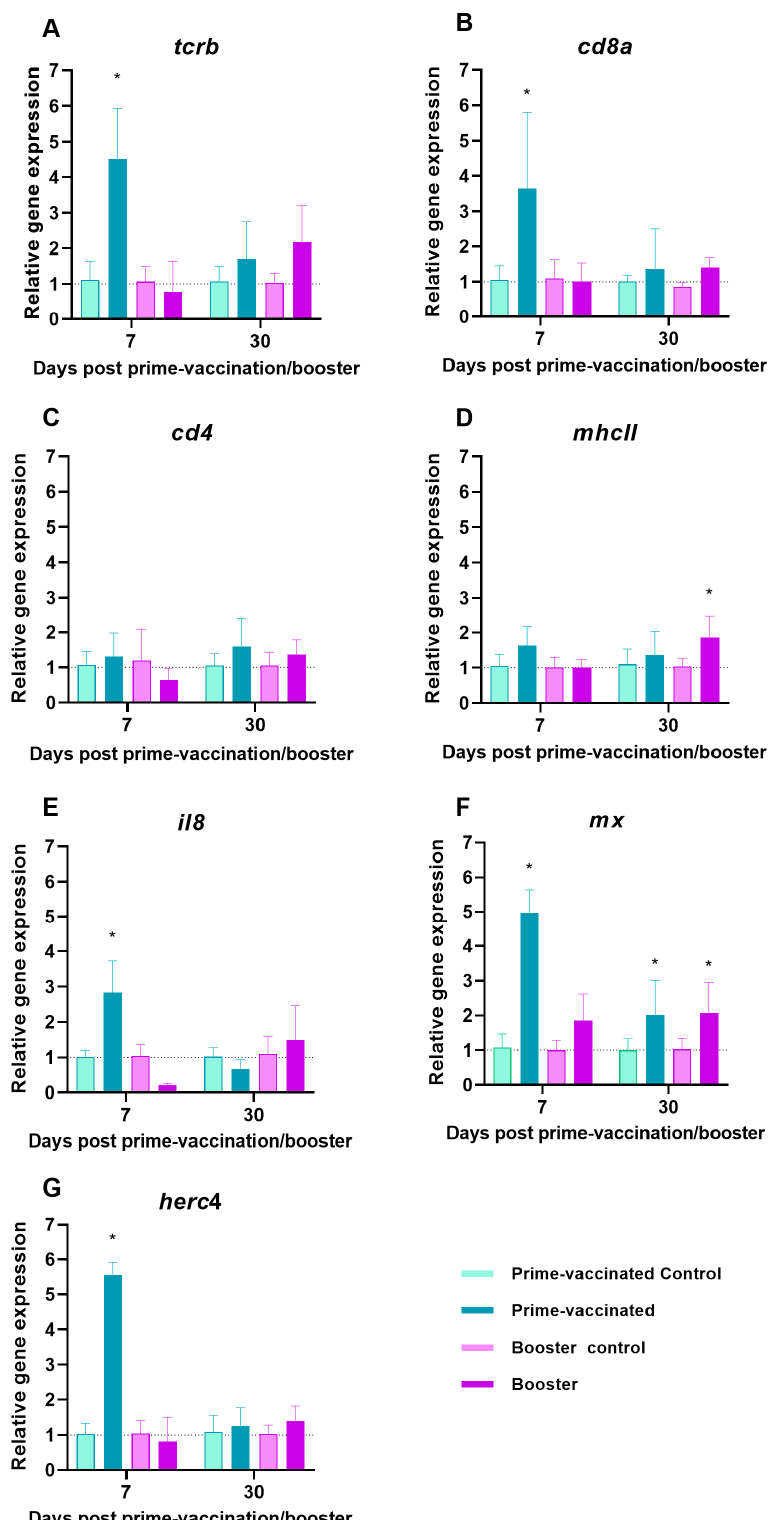
Figure 4. Expression of immune-related genes ( A ) tcrb , ( B ) cd8a , ( C ) cd4, ( D ) mhcII , ( E ) il8 ; ( F ) mx and ( G ) herc4 , in the head-kidney of Senegalese sole specimens 7- and 30-days after intraperitoneal vaccination or re-immunization with a BEI-inactivated vaccine or PBS (control). Data represent the mean ± standard deviation (n = 6 fish/group and time). Asterisks represent statistical differences between control and prime-vaccinated/booster groups ( p < 0.05).